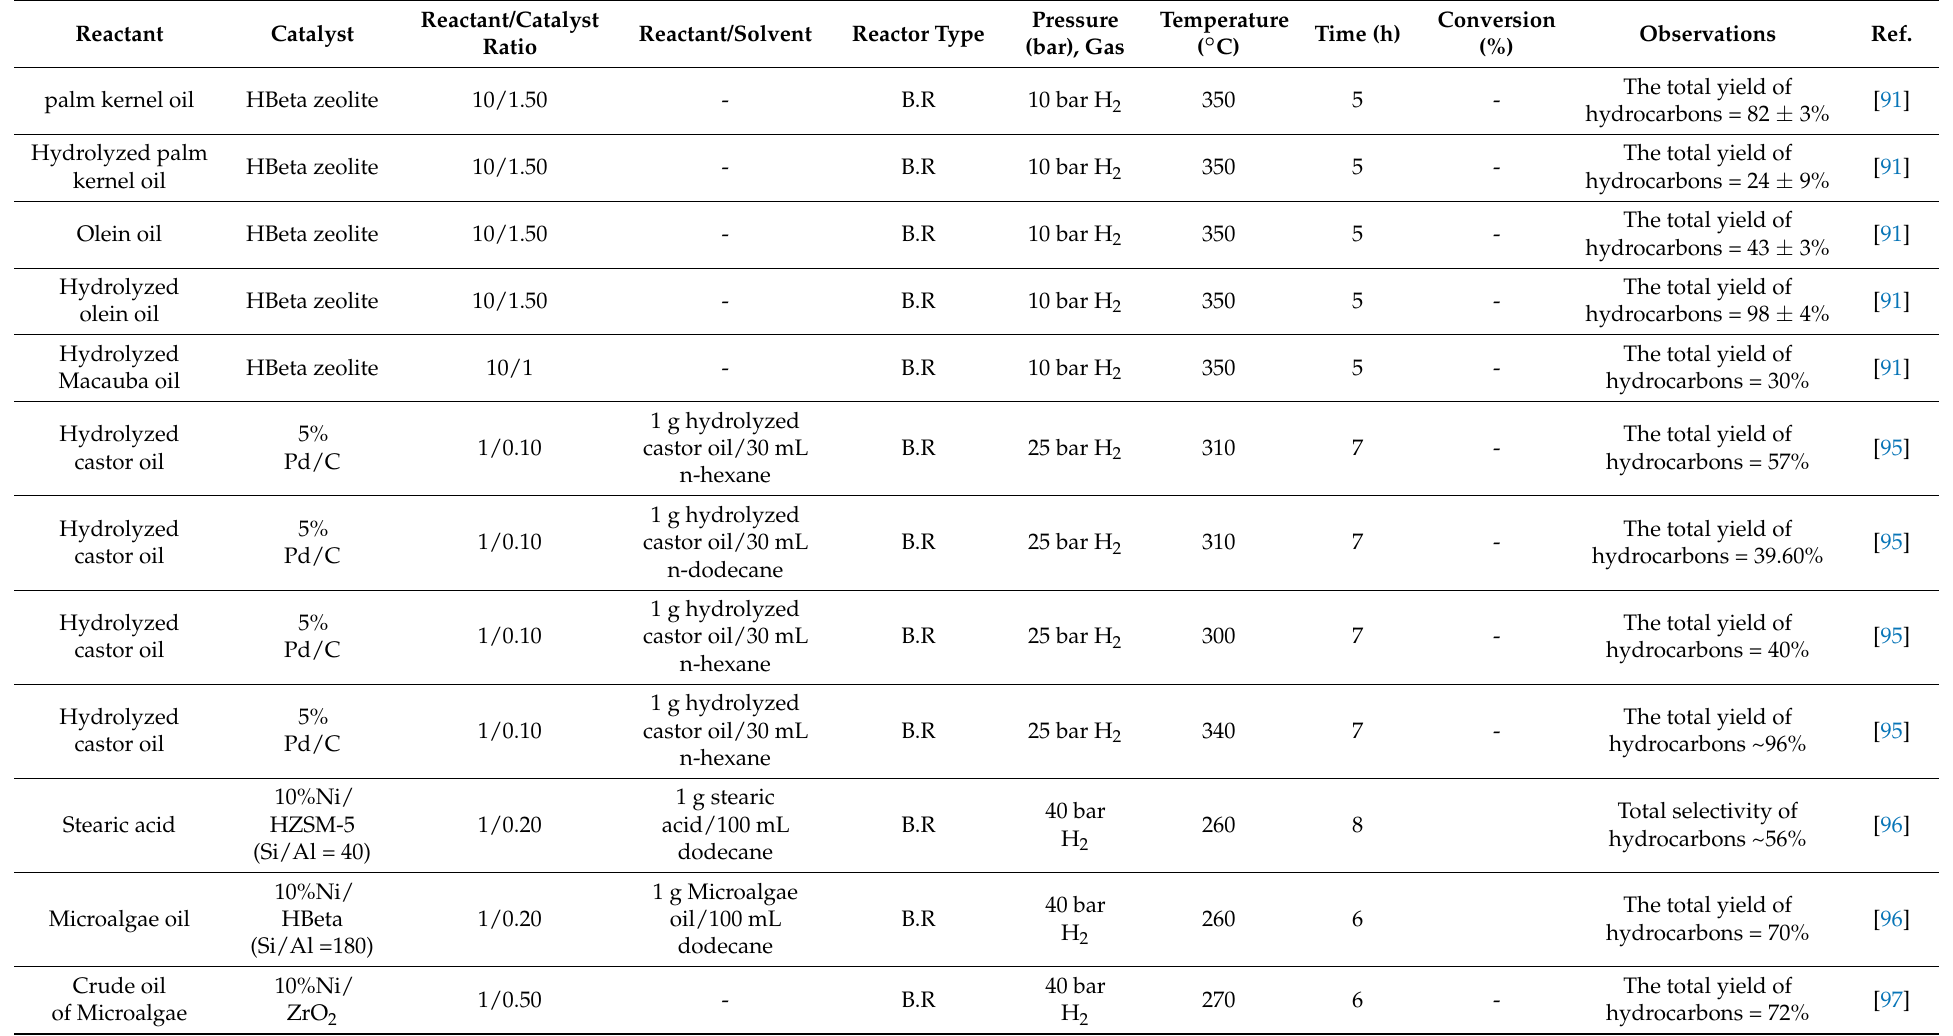
Table 6. Hydrocarbon productions via catalytic deoxygenation with various catalyst types in the references and catalytic deoxygenation in this